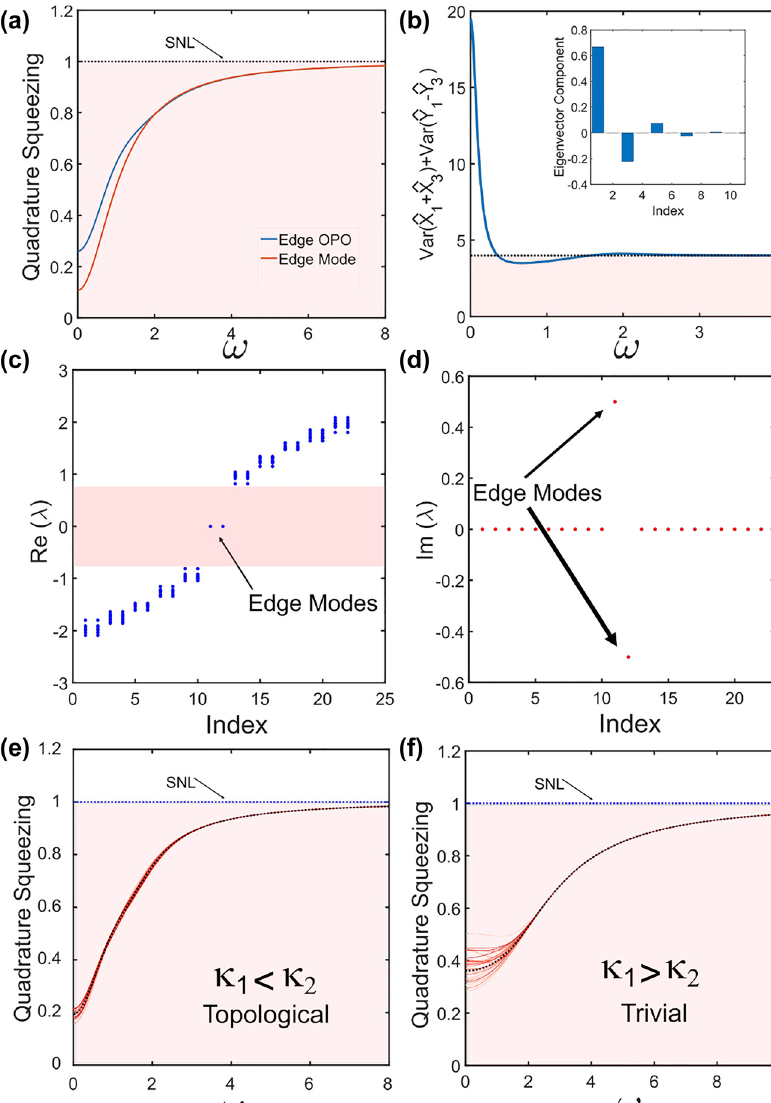
Figure4: Topologicalprotectioninthequan- tum